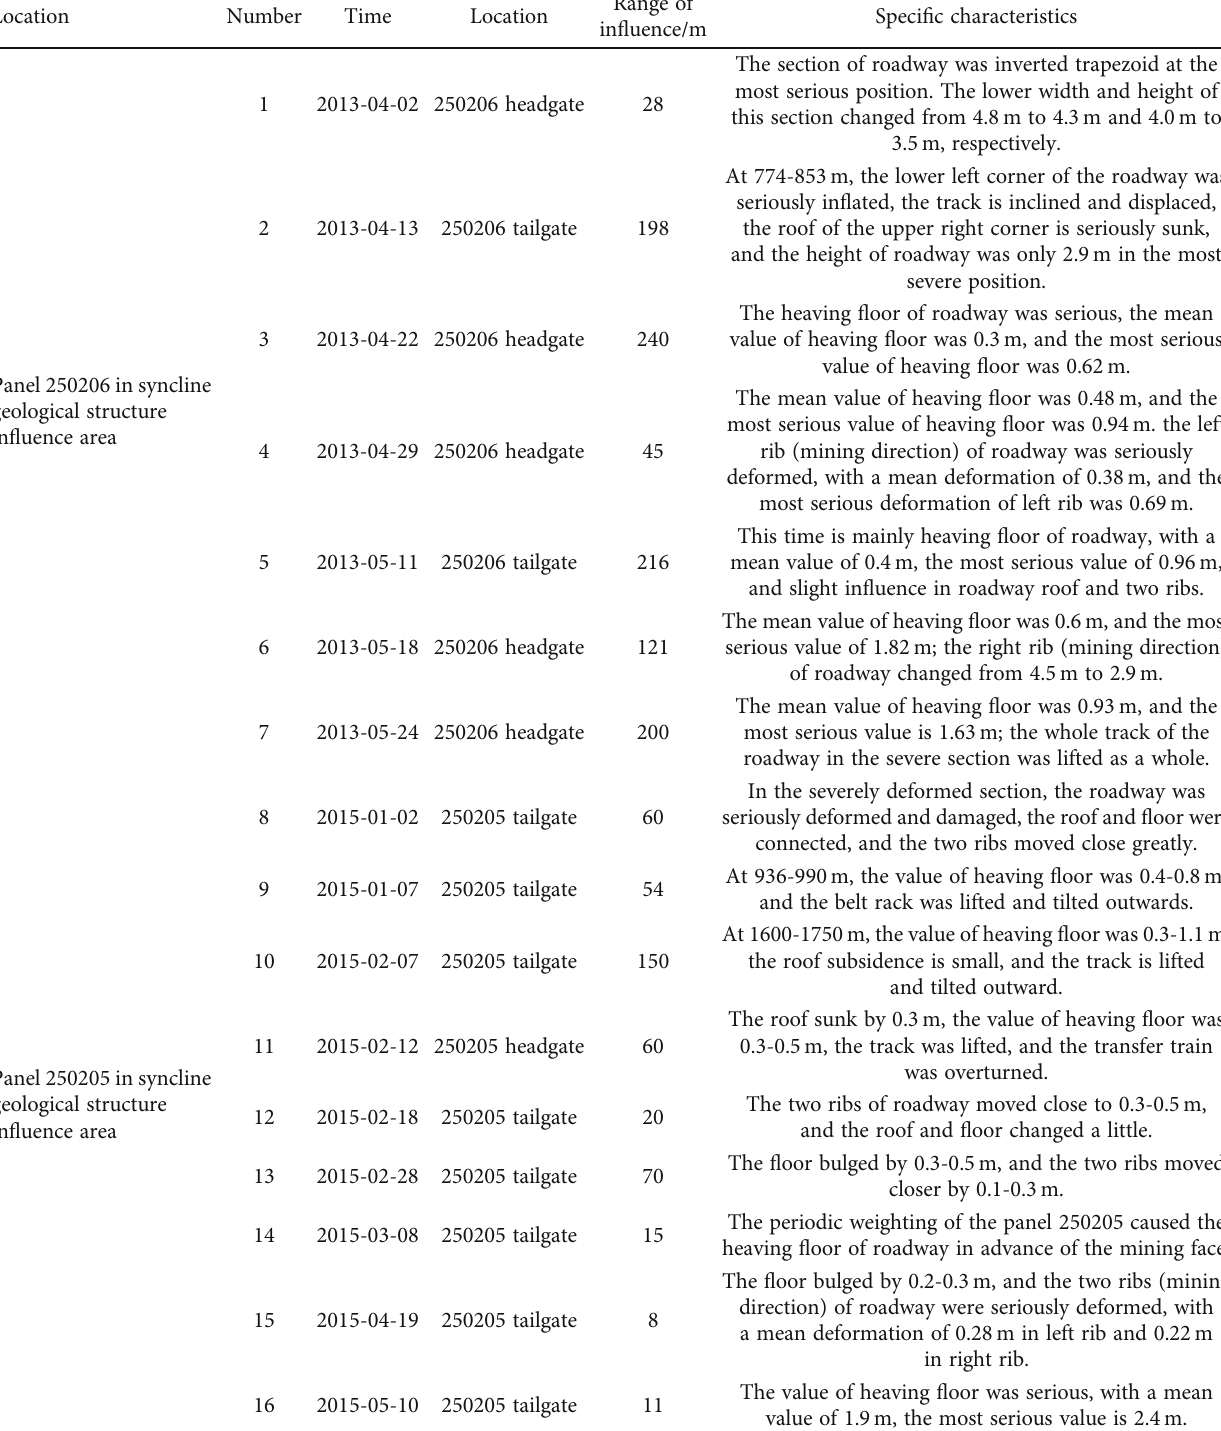
Table 7: The monitoring records of typical rock-burst